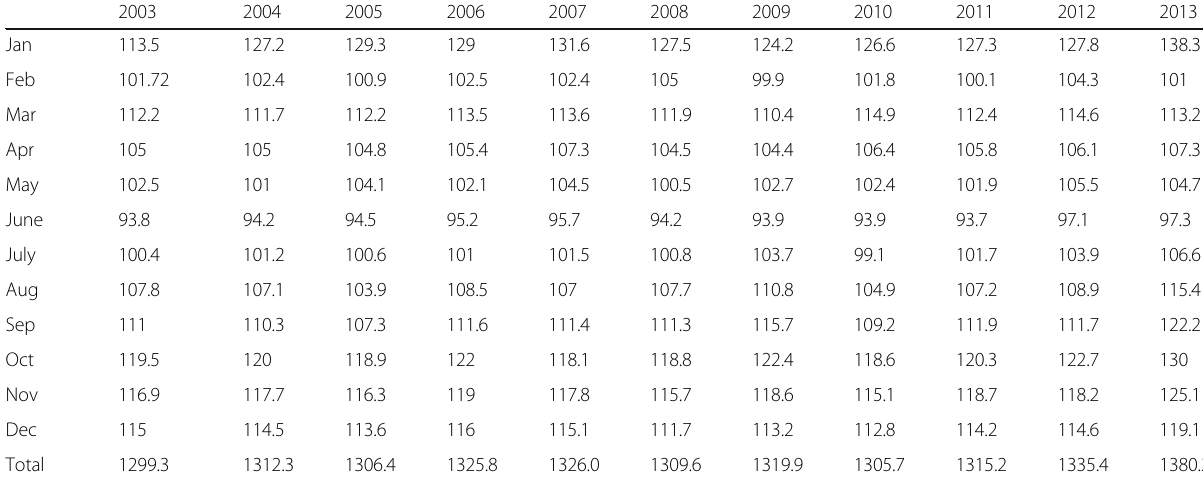
Table 6 Monthly ET values (mm) averaged for the entire Amazon basin